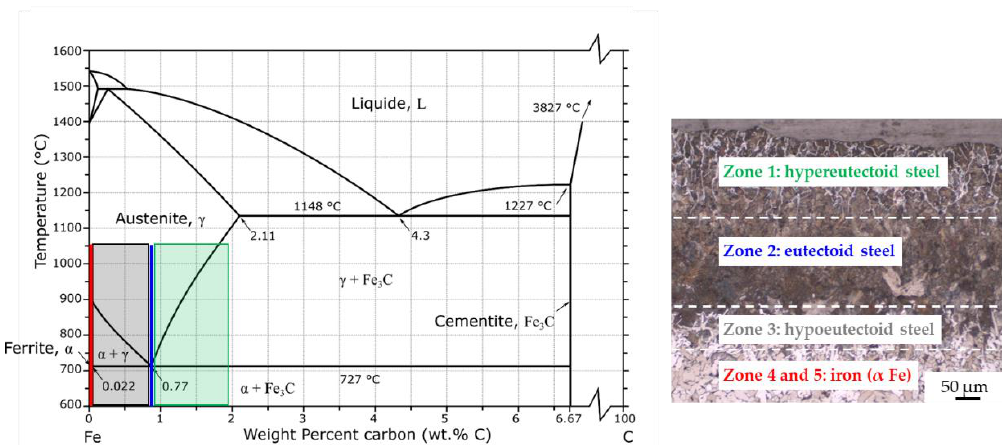
Figure 6. Correlation between Fe-C equilibrium diagram and the five zones observed in the sintered iron (sintering with graphite foils without coating).